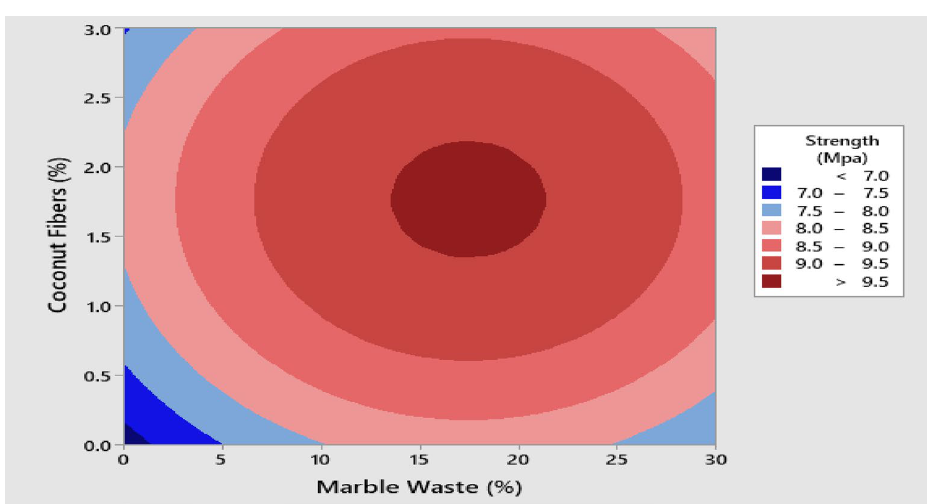
Figure 16. Contour plot for split tensile